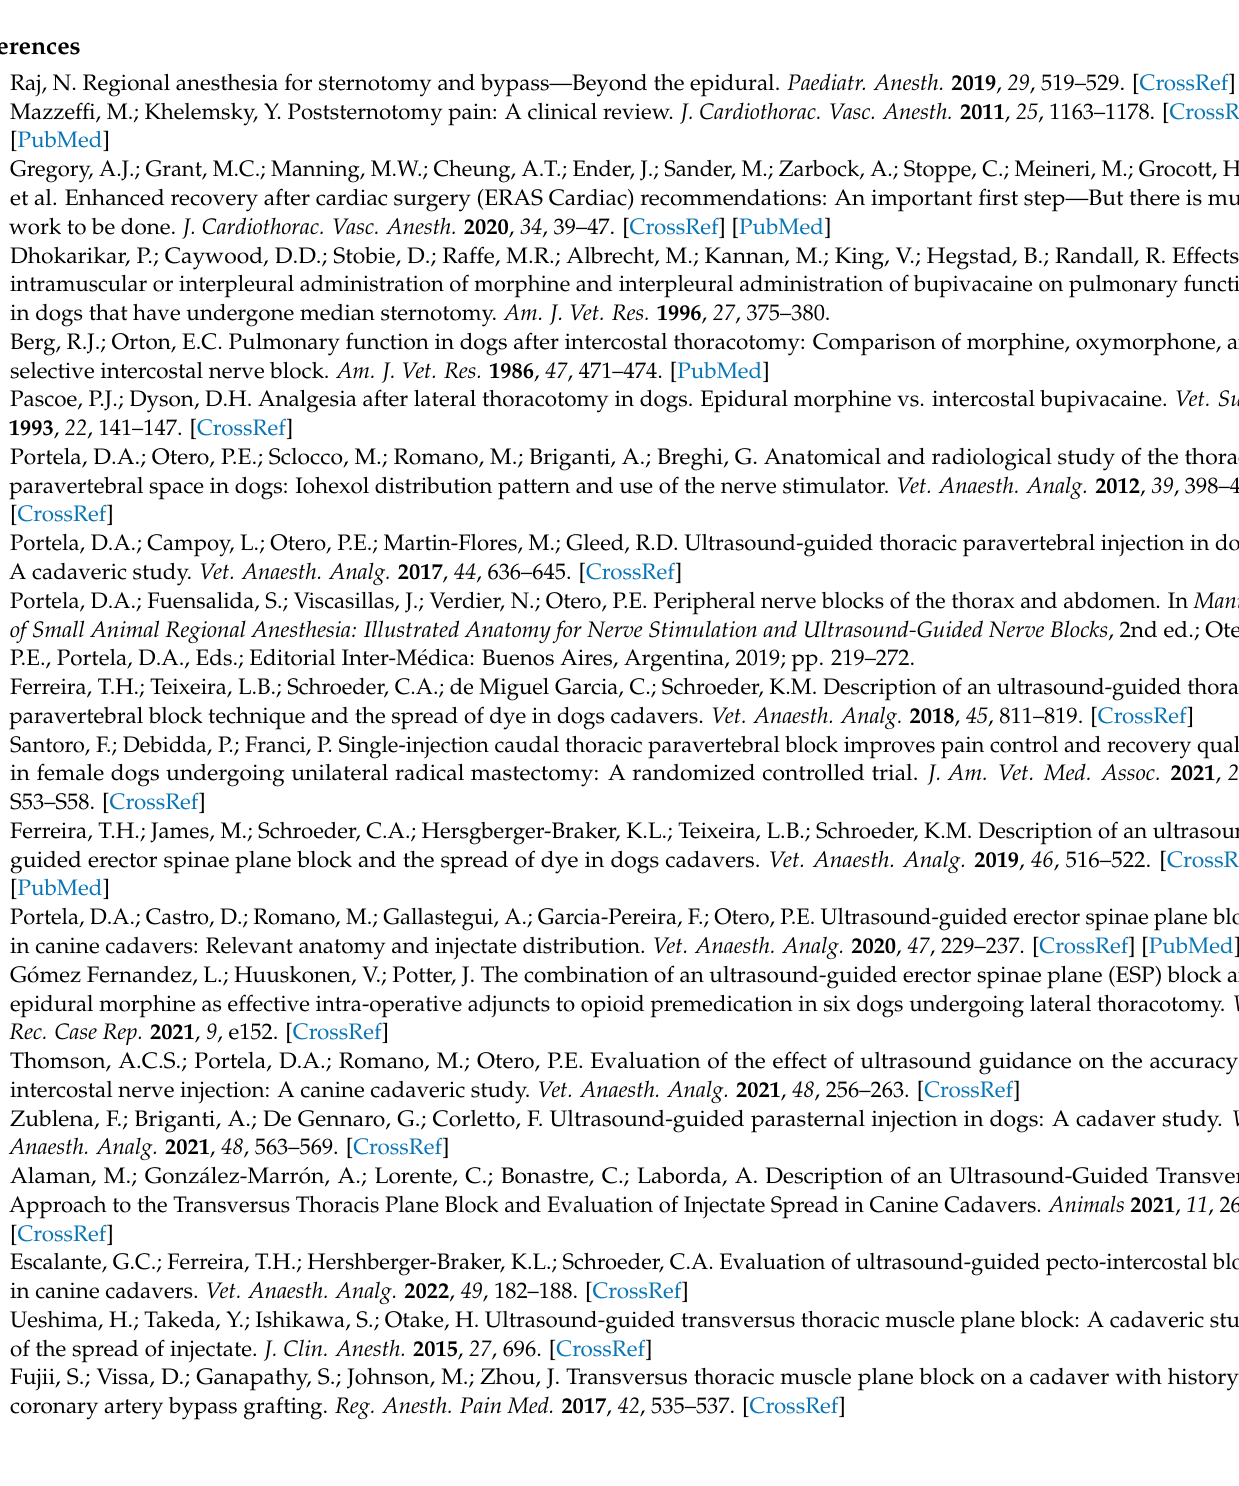
Table A1. Grading ultrasonographic visualization of the needle. Grade Description Good The shaft and the tip of the needle can be completely visualised The needle tip is only visualized after gentle in- and out- movements or Poor jiggling of the needle. Absent The needle tip cannot be